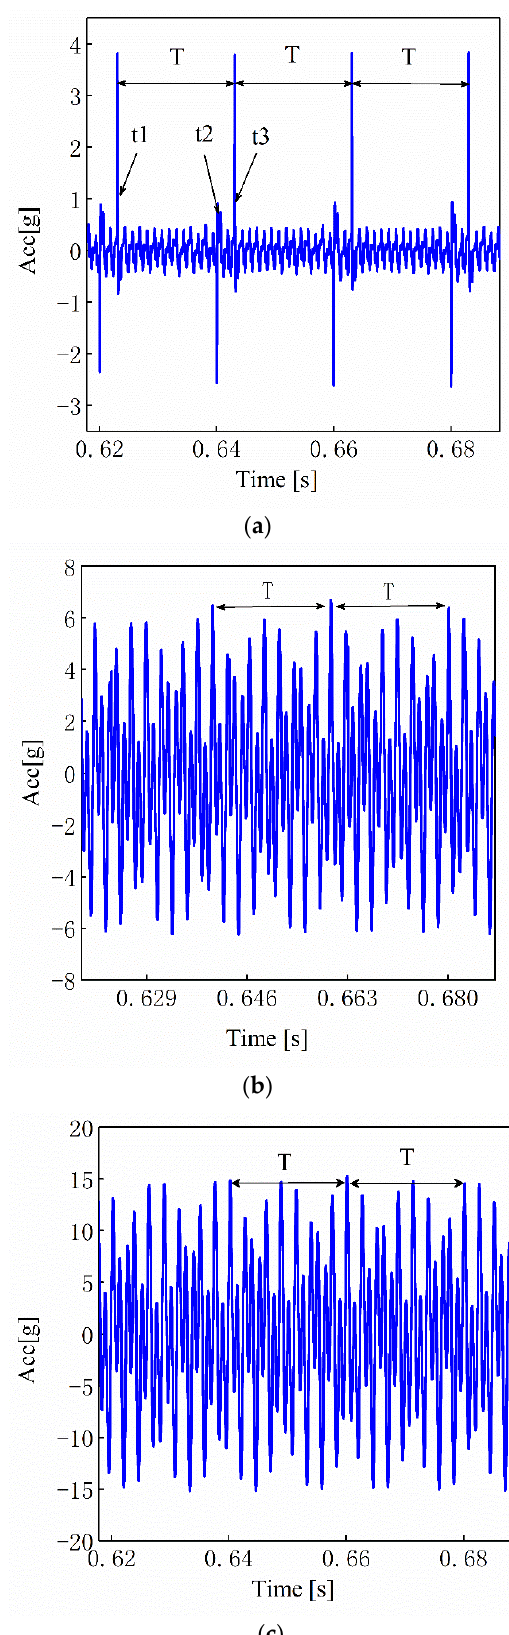
Figure 19. The acceleration of the gear with crack fault under different transmission error ampli ‐ tudes. ( a ) e = 0. ( b ) e = 20 um. ( c ) e = 50 um.